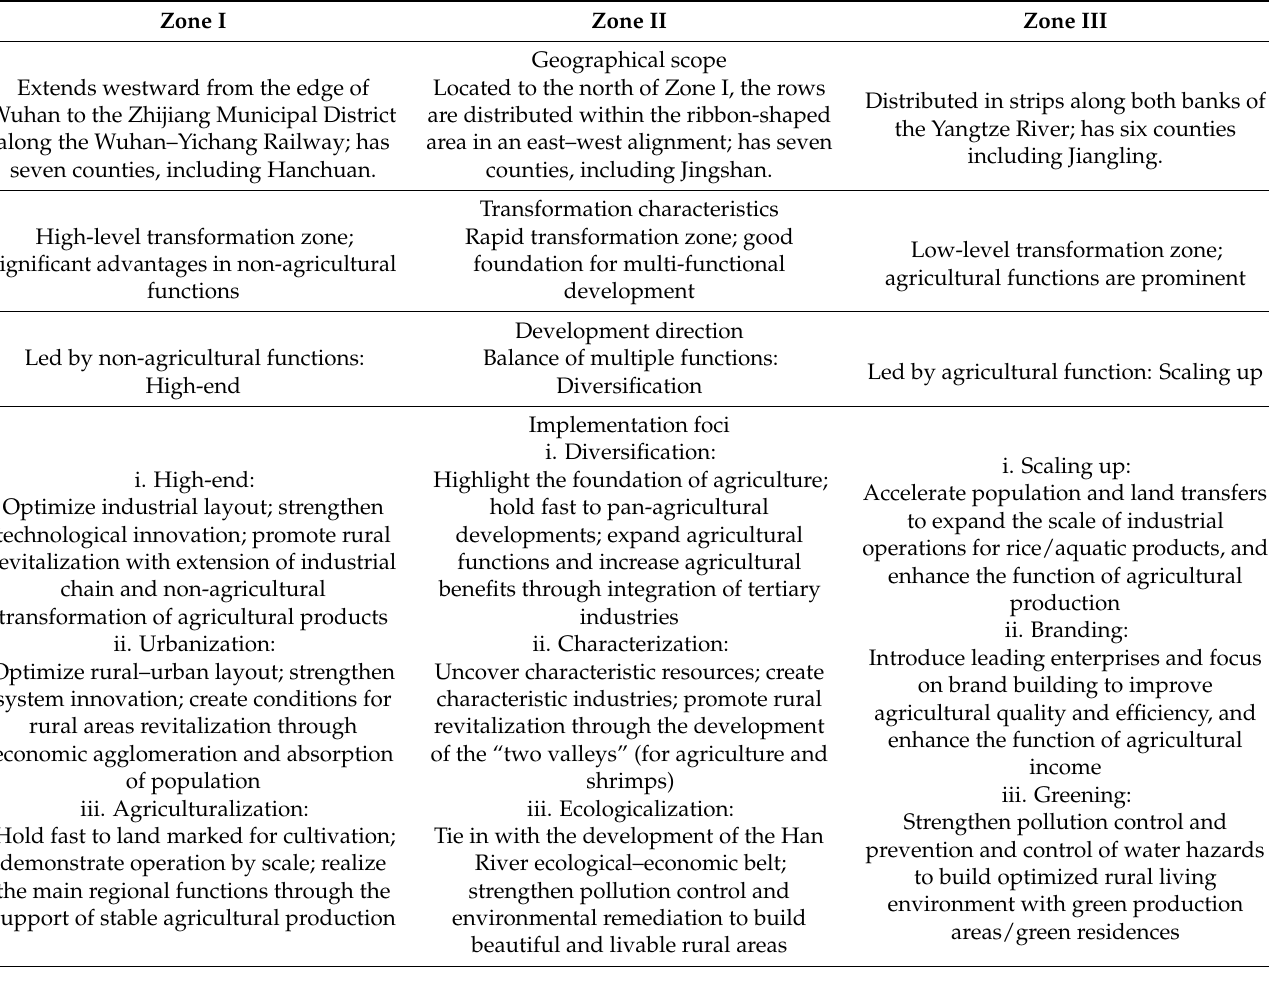
Table 6. Zonal characteristics and implementation paths of rural